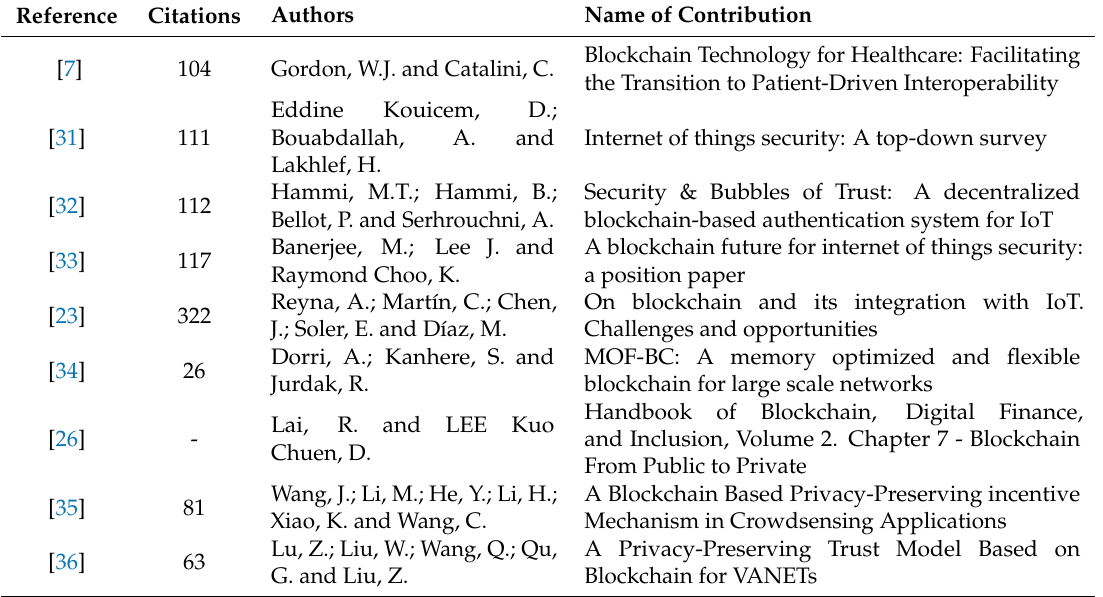
Table 3. Influence of selected